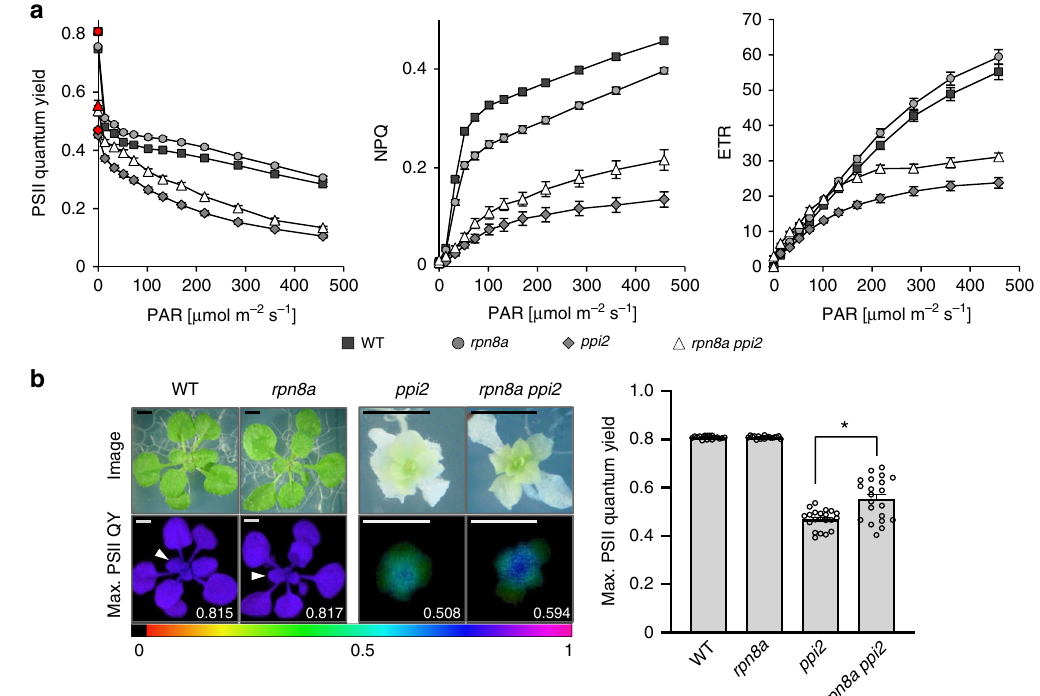
Fig. 3 Photosynthetic performance determined by chlorophyll fl uorescence measurements. a Imaging PAM determination of PSII quantum yield and activity (left graph), non-photochemical quenching (NPQ) (middle graph) and electron transport rate (ETR) (right graph) for wildtype (WT), rpn8a , ppi2, and rpn8a ppi2 ( n = 18 in case of green plants, n = 21 in case of albino plants), error-bars represent SEM. b Graphical representation of maximum PSII quantum yield (left: fl uorescence images, right: column representation of determined max. PSII quantum yield ( n = 21, T -test, two-sided, p -value < 0.001 (one star)) Error-bars represent SEM, the scale bars represent 0.2 cm.